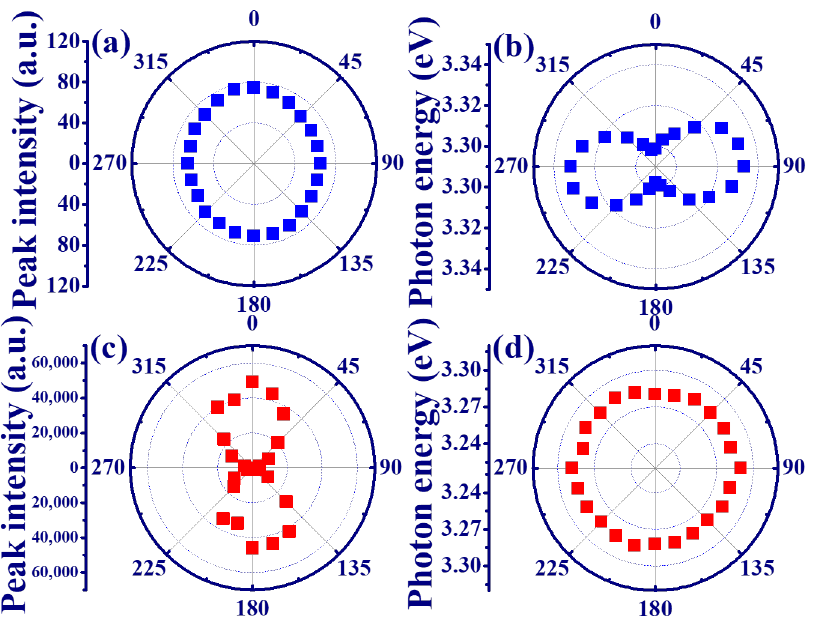
Figure 3. Polar plots of ( a ) peak intensity and ( b ) photon energy of the SPE as well as the ( c ) peak intensity and ( d ) photon energy of the ASE from the edge emission of the